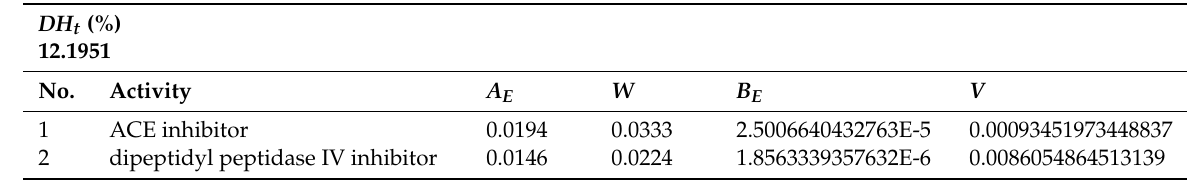
Table A46. A E , DH t , W , B E and V values from RubisCO of Halophila stipulacea . In silico enzymatic cleavage was carried out by using oligopeptidase